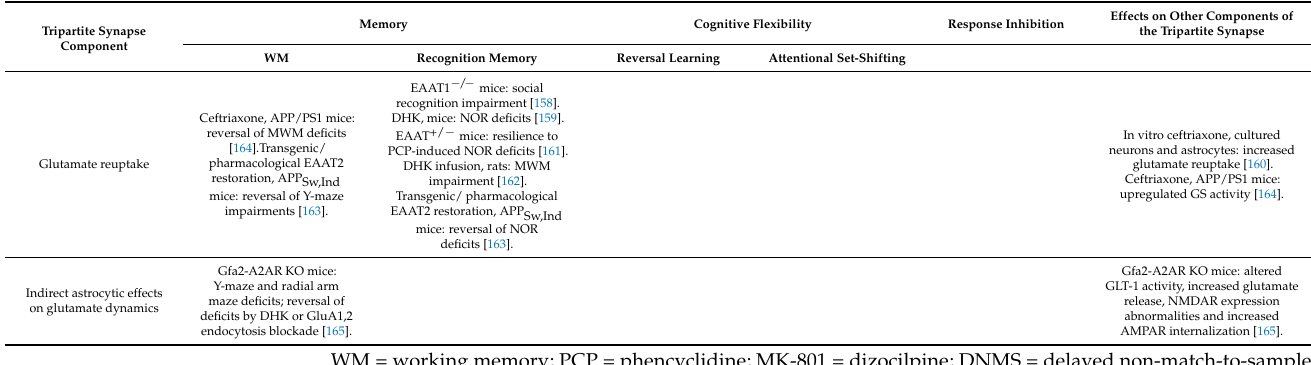
Indirectastrocyticeffects onglutamatedynamics